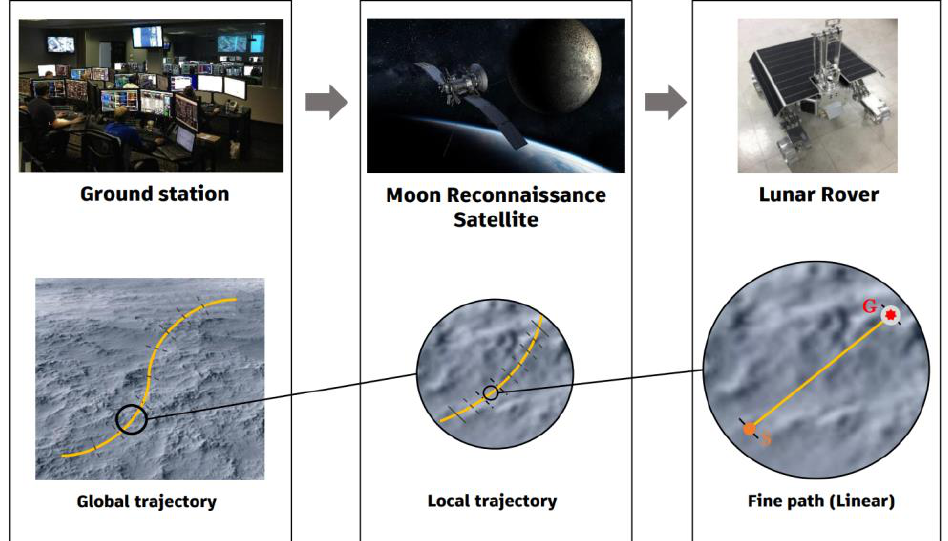
Figure 8. Rover motions required by sequence-based commands for a Moon exploration mission.